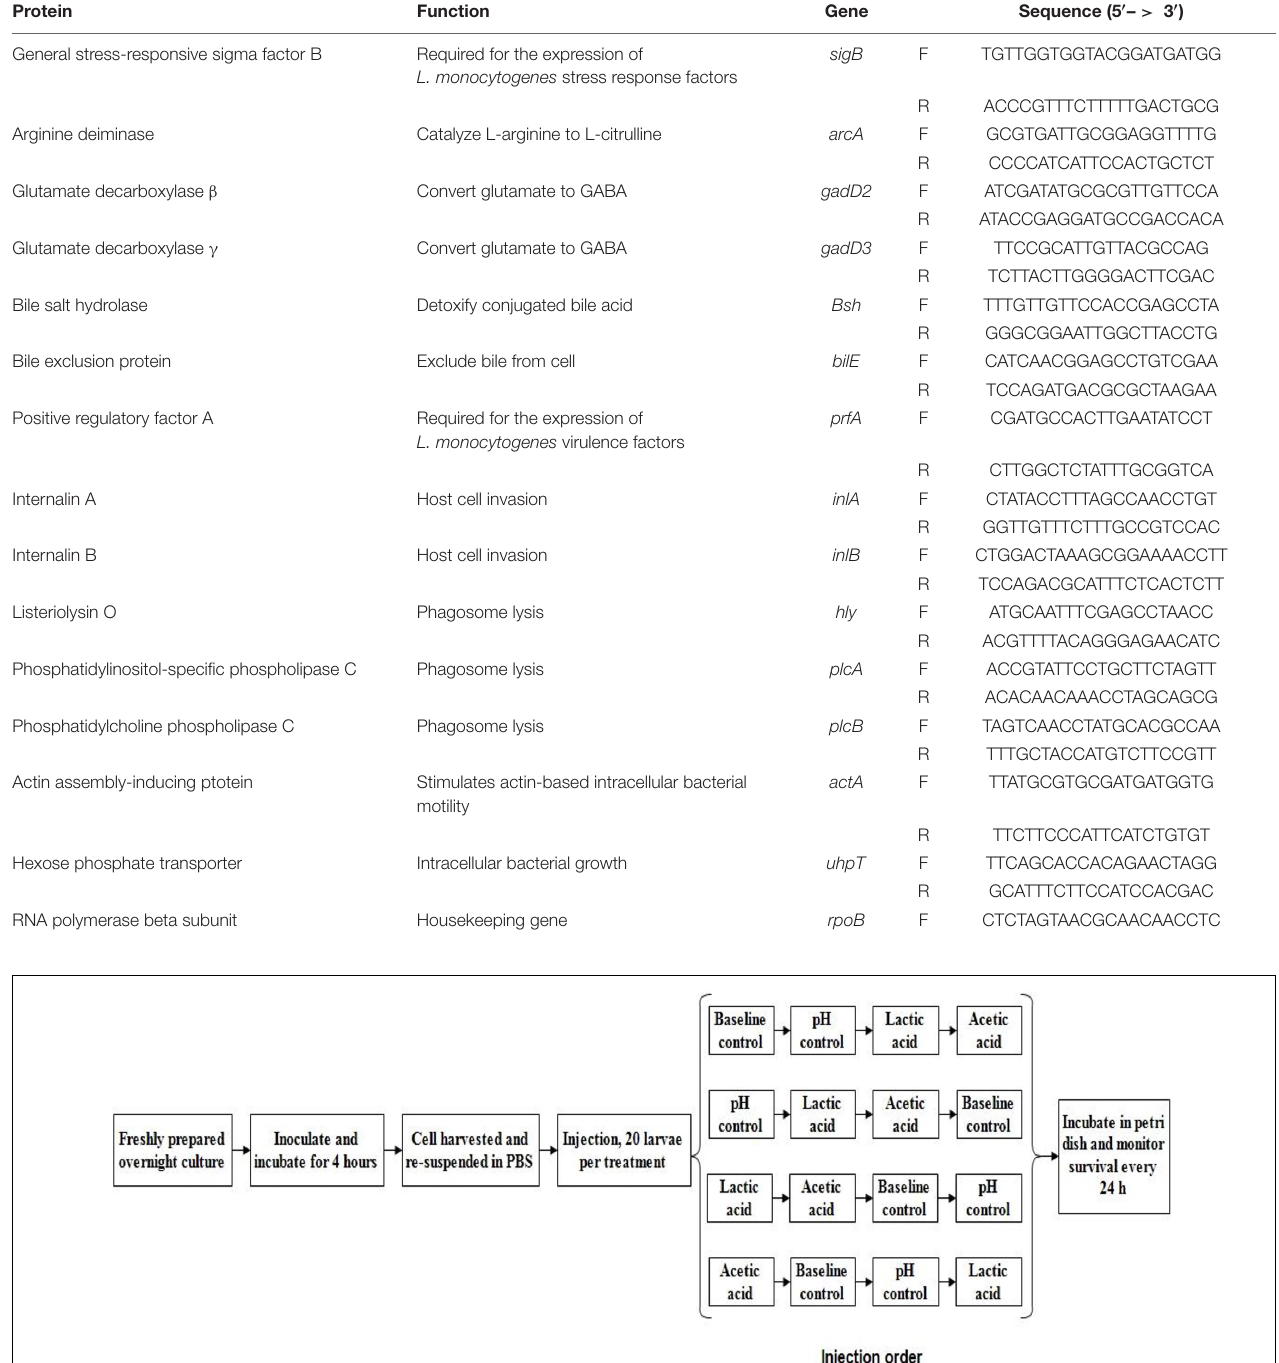
larvae were collected and homogenized in 9 mL of sterile peptone physiological solution (PPS) in a stomacher. Serial dilutions were made by pipetting 1 mL of diluted sample into